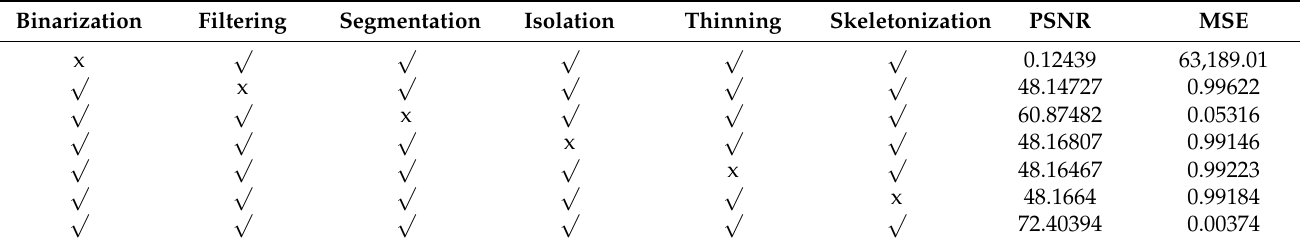
Table 4. Results of preprocessing on the CEDAR